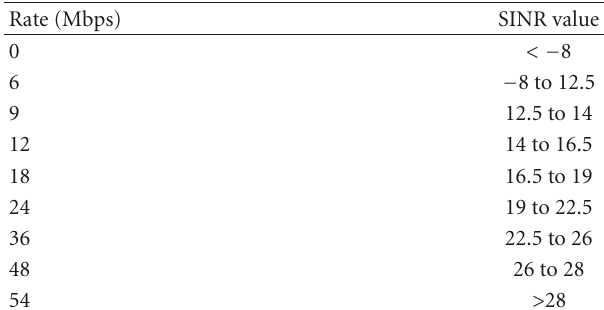
Table 1: SINR values mapping to